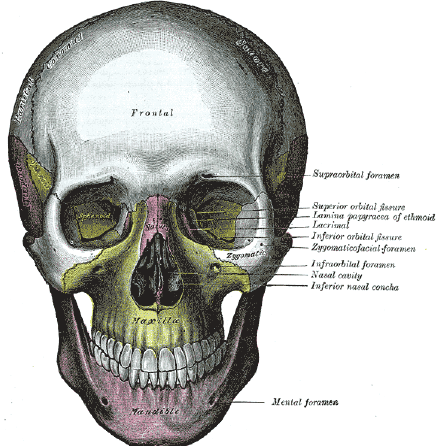
Figure 1. Craniofacial bones